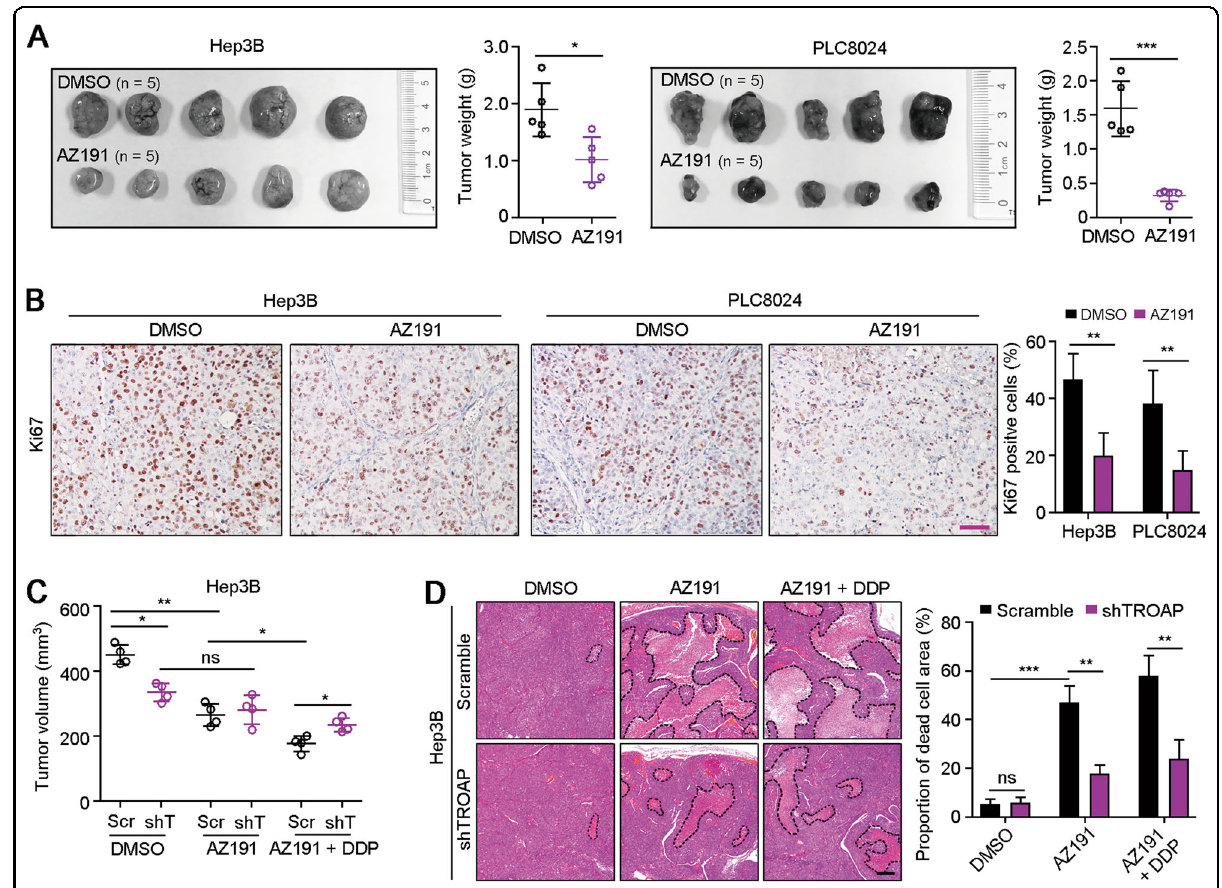
Fig. 6 Combination of AZ191 and cisplatin suppresses HCC cell growth in nude mice. A Hep3B and PLC8024 cells were subcutaneously injected into nude mice. One week after injection, mice were treated with DMSO or AZ191 (50 mg/kg, i.p .) for six times, and tumor weights were measured after sacri fi ce of mice. B IHC staining with antibody against Ki67 in xenograft tumors treated with or without AZ191. The percentage of Ki67 positive cells were summarized in right panel. C Subcutaneous xenograft tumors derived from Hep3B cells transfected with scramble RNA (Scr) or shRNA targeting TROAP (shT) were treated with DMSO, AZ191 or/and cisplatin (DDP, 6 mg/kg, i.p .). Tumor volumes were measured after six times treatments. D H&E staining of xenograft tumors after treatments. The proportion of dead cell area was analyzed with ImageJ software and summarized in the right panel. In all panels, data were indicated as mean ± SD; two-sided Student ’ s t -test; * P < 0.05; ** P < 0.01; *** P < 0.001; ns, no statistical signi fi